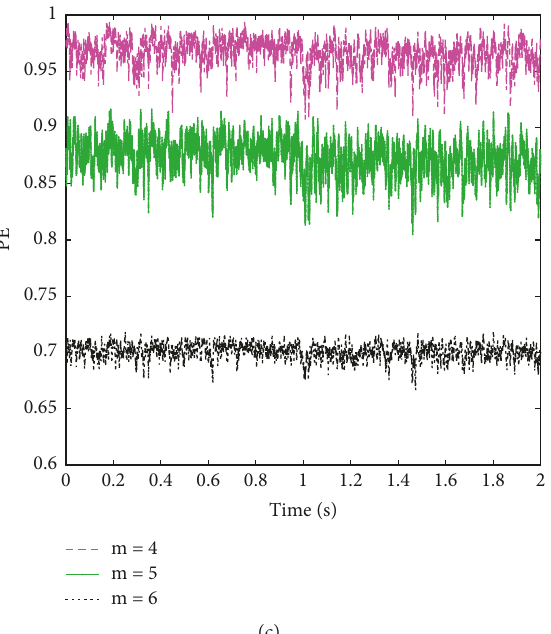
Figure 2: The calculation values of permutation entropy with different m and t. (a) t � 1 and m � 4, 5, and 6. (b) t � 2 and m � 4, 5, and 6. (c) t � 3 and m � 4, 5, and